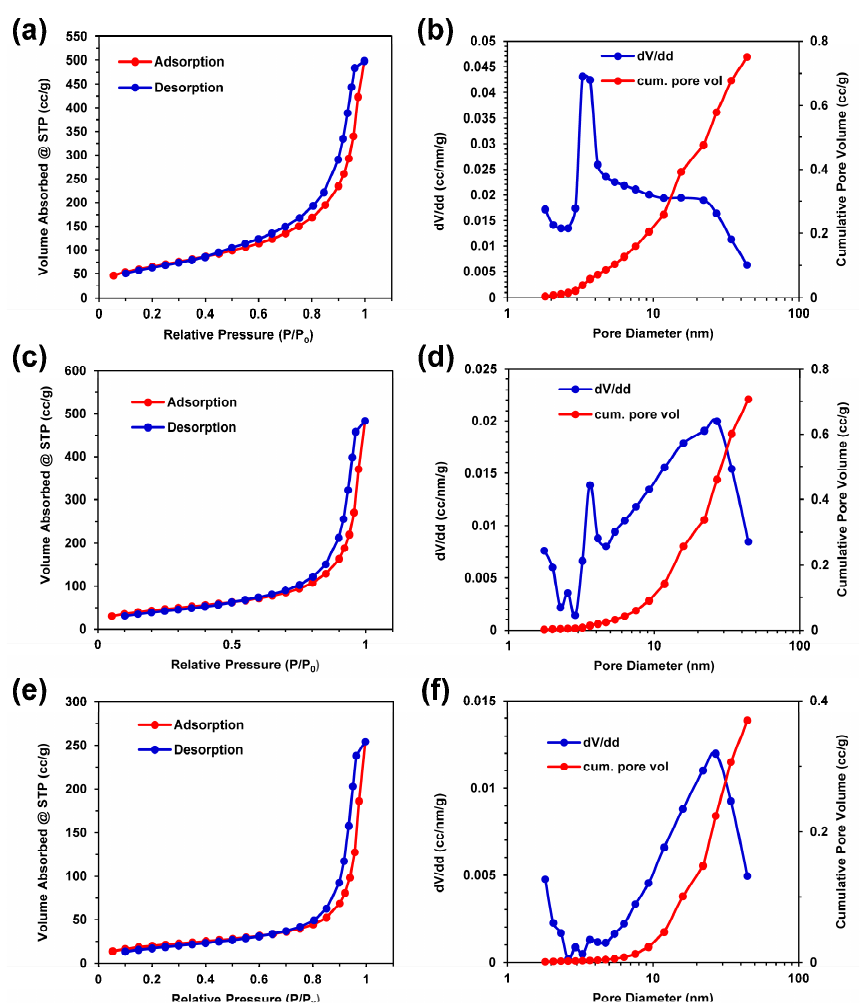
Figure 5. Nitrogen adsorption–desorption isotherms and pore size distribution with cumulative pore volume for the ( a , b ) silk aerogels, ( c , d ) palladium–silk aerogels, and ( e , f ) platinum–silk aerogels.